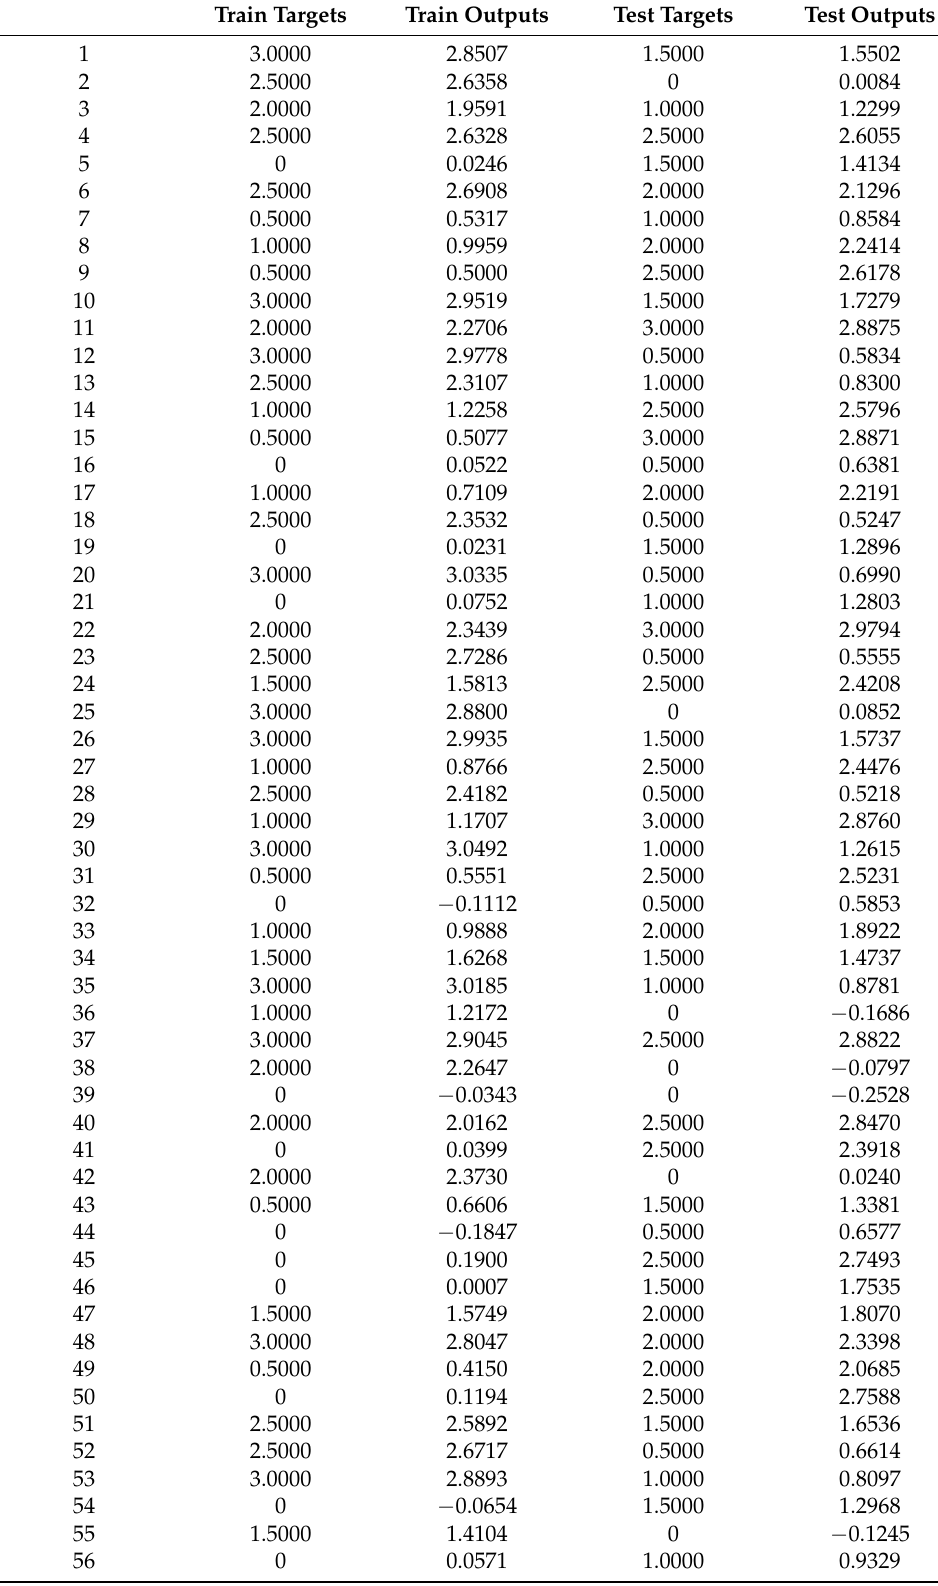
Table 1. Comparison of target values with neural network